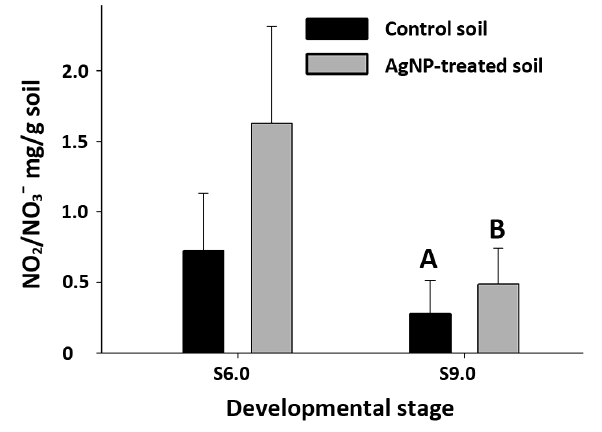
Figure 5. Inorganic nitrogen nutrients in soil. Inorganic nitrate/nitrite contents of soil were measured after plant tissues were harvested at S6.0 and S9.0. At S6.0, there was no significant difference between control and treated soil. However by S9.0, more nitrate/nitrite remained in the AgNP-treated soil than control